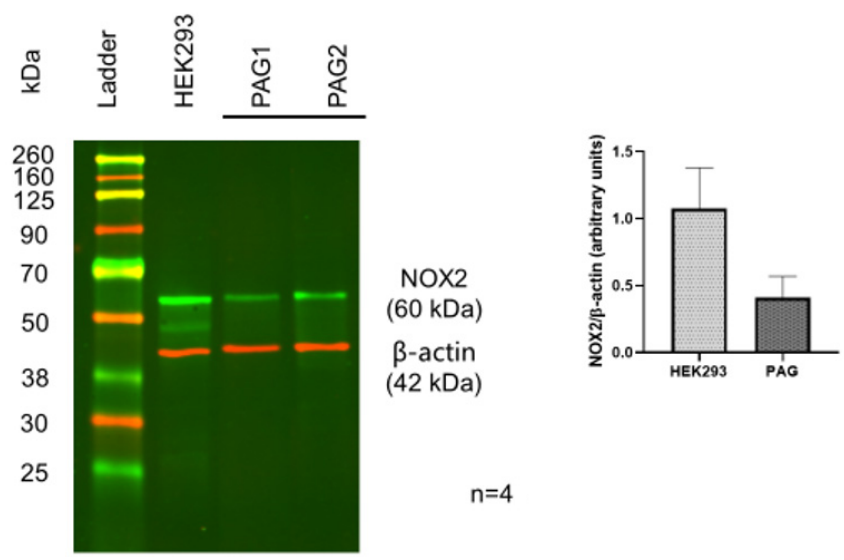
Figure 1. Western blot of Nox-2 in PAG from the mouse brain. HEK293 cells served as a positive control. Data show positive expression of Nox-2 in PAG, comparable to that in HEK293 cells.